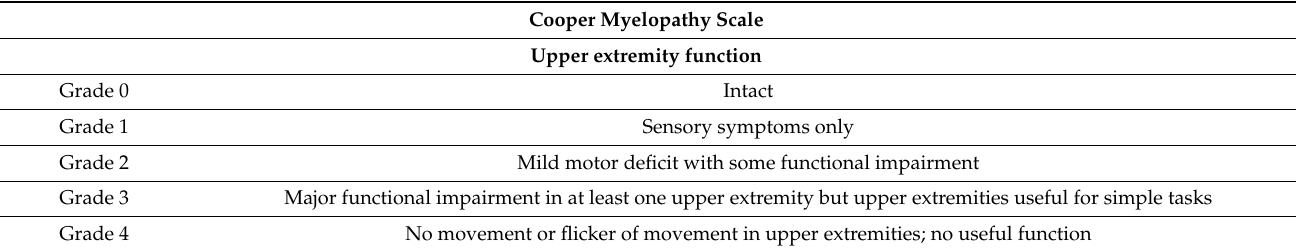
Table A7. Cooper Myelopathy Scale